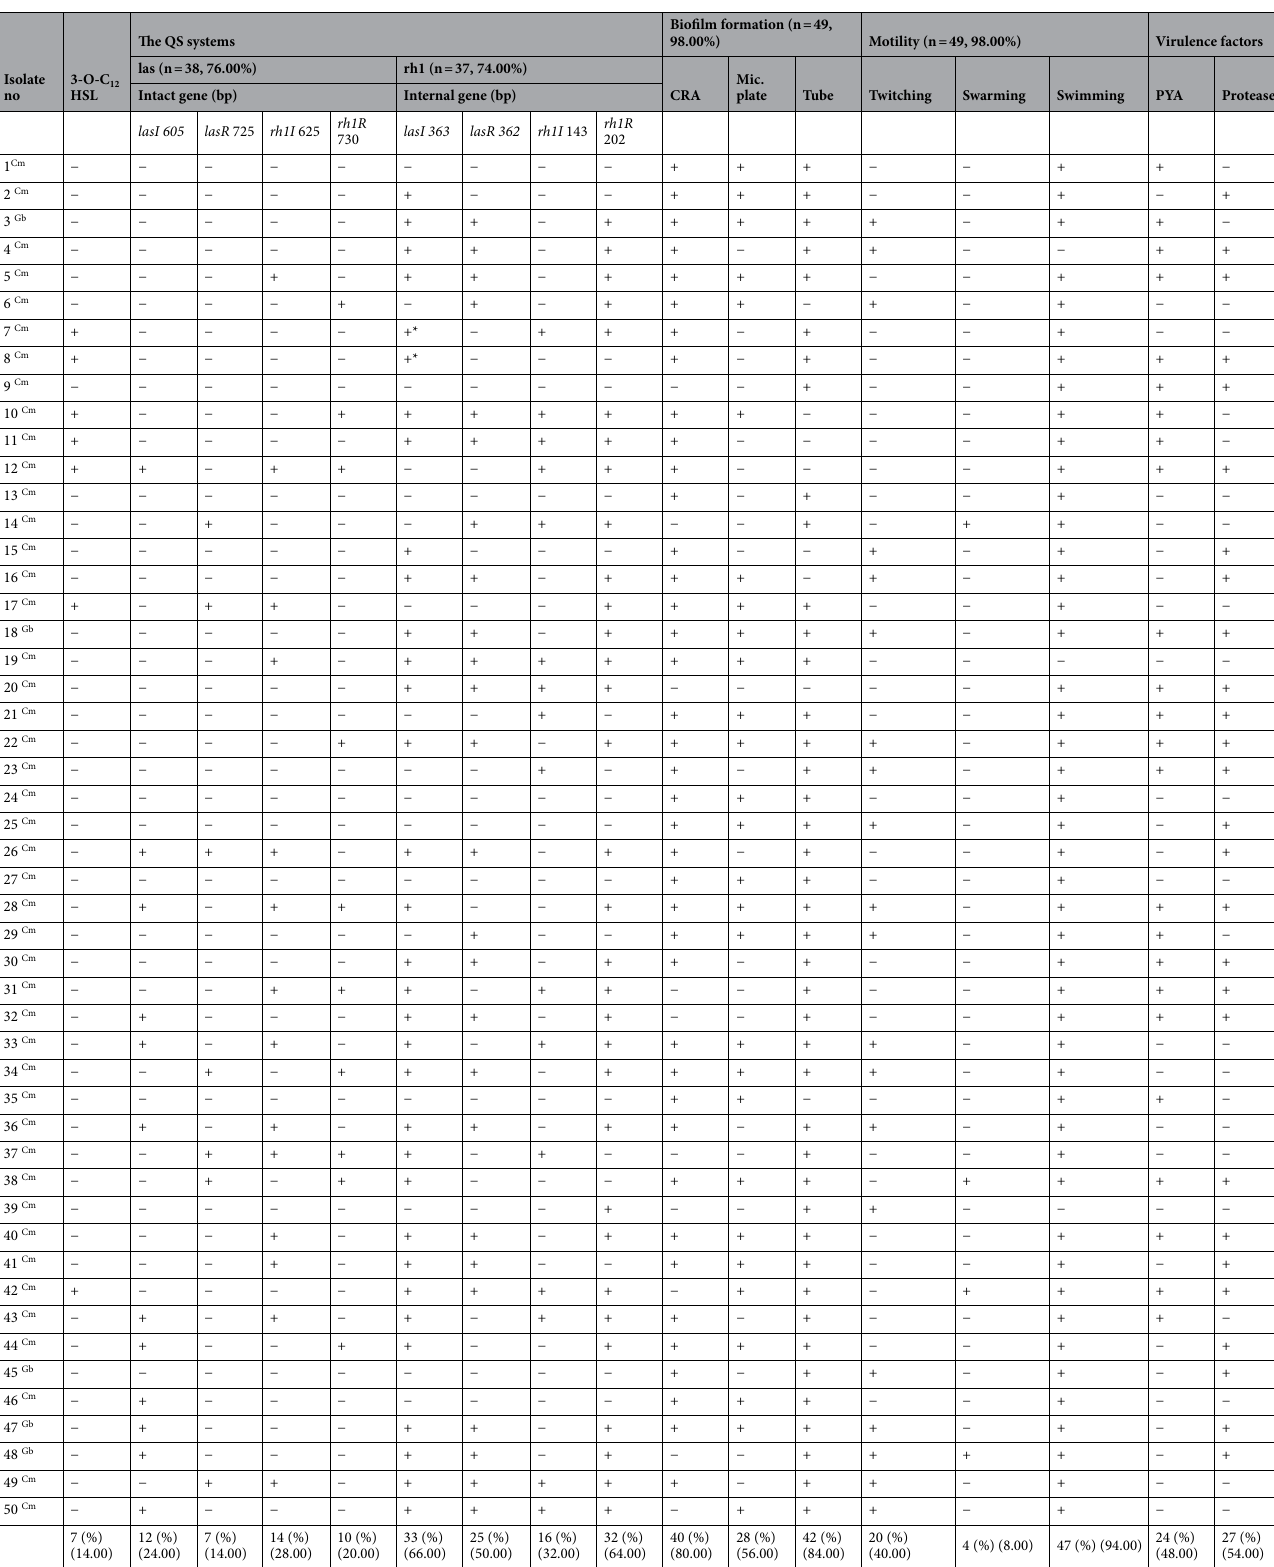
Table 2. HSL, the QS-system genes, biofilm formation, motility, PYA, protease and elastase activity test results of the 50 P. aeruginosa isolates. Cm : Chicken meat; Gb : Ground beef; *Based on the according to third primer set described by Zhu et al. 46